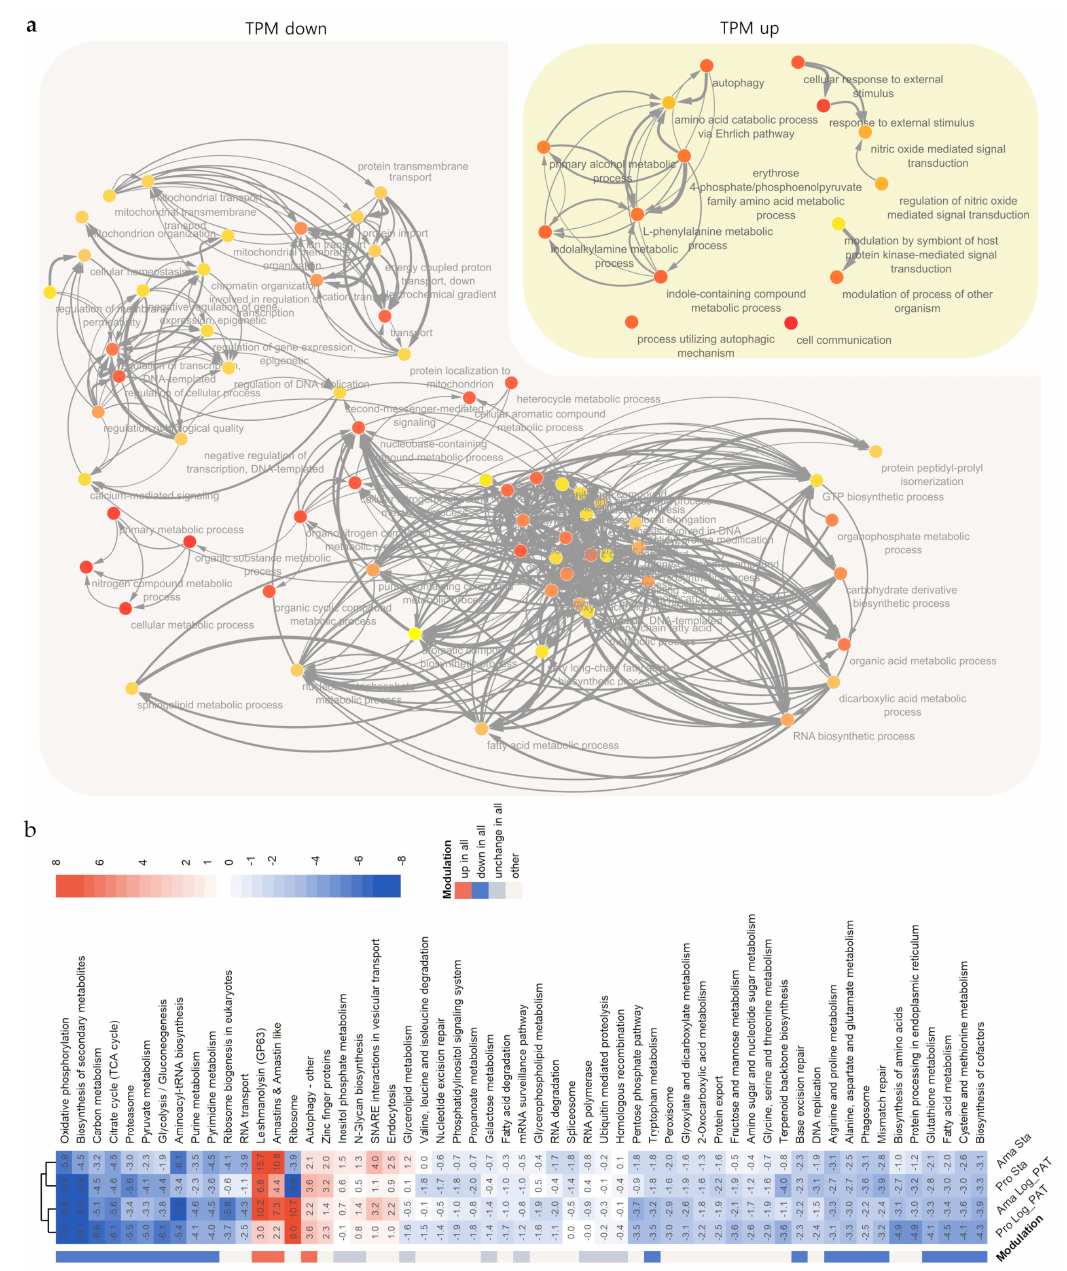
Figure 4. ORA and GSEA analysis. ( a ), ORA and network analysis for the core set of mRNAs modulated and shared among all quiescent conditions. ORA indicated that many biosynthetic processes are downregulated, while few processes related to ‘cell host modulation’ and the recycling of nutrients are upregulated. The color of the bubble from yellow to orange indicates more significant adjusted p values (cutoff adj p < 0.05). ( b ), GSEA shows the major set of mRNAs upregulated and shared among all quiescent cells correspond to: leishmanolysin (GP63), amastin and amastin-like proteins, and autophagy-related genes. On the contrary, among other processes, the biosynthesis of several amino acids and biosynthesis of aminoacyl tRNA are downregulated in all quiescent cells, regardless of the stimuli. The absolute value in each cell of the heatmap measures the magnitude of gene-set changes in log2 scale, and its sign indicates the direction of the change. The modulation of a particular set was considered up in all (red) or down in all (blue) if the p values were statistically significant in all conditions. While it was considered unchanged (grey) if the p value in all conditions were non-significant. Additional details are in Table